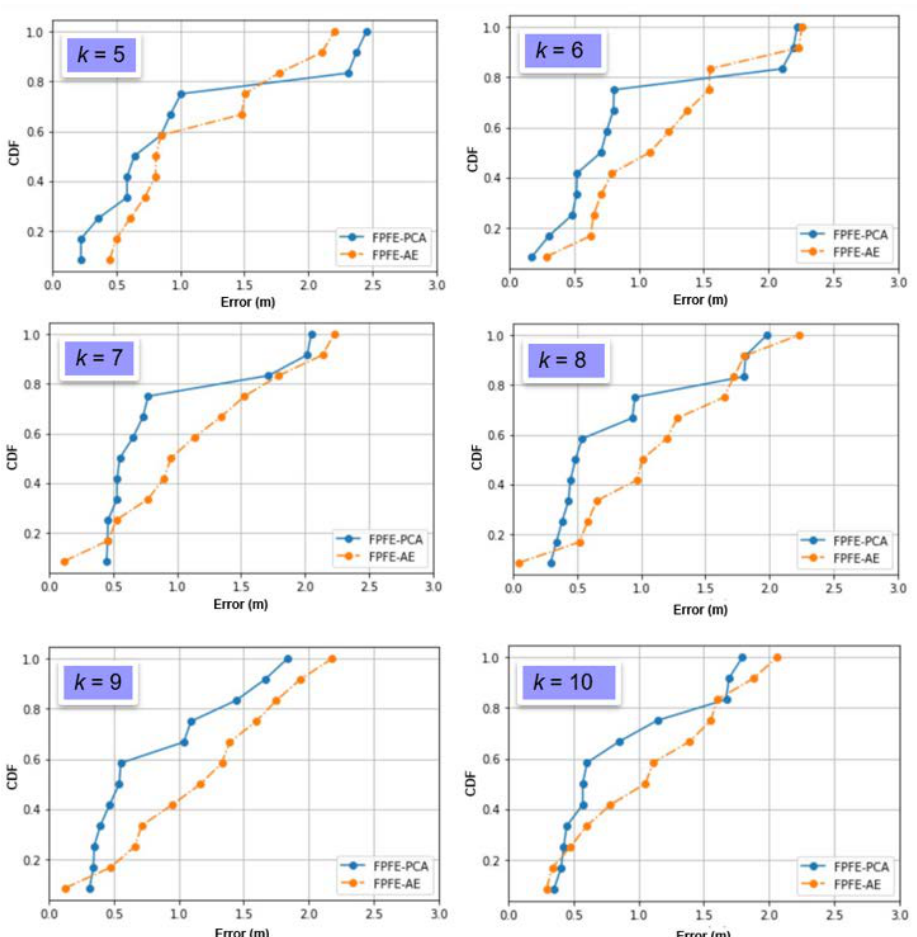
Figure 11. The localization error box and whisker plots of FPFE with 54 grid RPs for k RP candidates, where k = 5, 6, 7, 8, 9, and 10.